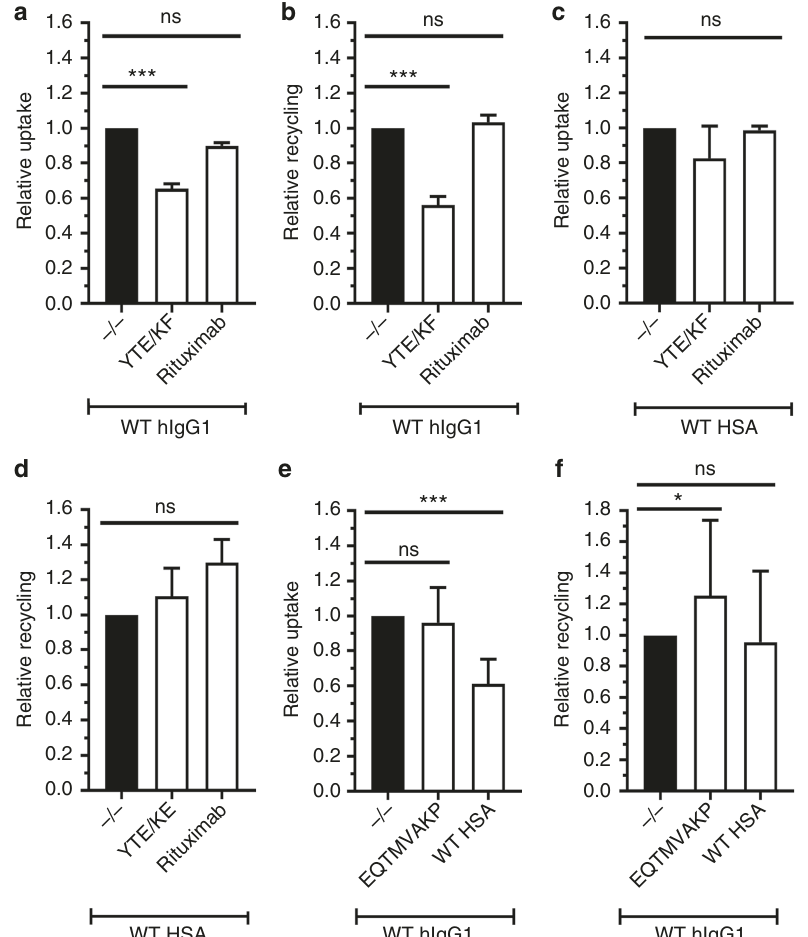
Fig. 8 YTE/KF is inhibiting rescue of IgG from degradation but not albumin. Relative a uptake and b recycling of WT hIgG1 in the absence or presence of excess amounts of YTE/KF or rituximab after 4 h incubation at pH 7.4. c Relative uptake and d recycling of WT HSA in the absence or presence of excess amounts of YTE/KF or rituximab after 4 h incubation at pH 7.4. e Relative recycling and f uptake of WT hIgG1 in the absence or presence of excess amounts of EQTMVAKP or WT HSA after 4 h incubation at pH 7.4. The amounts of WT hIgG1 and WT HSA were quanti fi ed using ELISA. Obtained data are shown as mean ± s.d. of a – d three and e , f six independent experiments performed in a – d duplicates and e , f triplicates. ns > 0.05, * p < 0.05, *** p < 0.001, by one-way ANOVA (Dunnett ’ s multiple comparisons